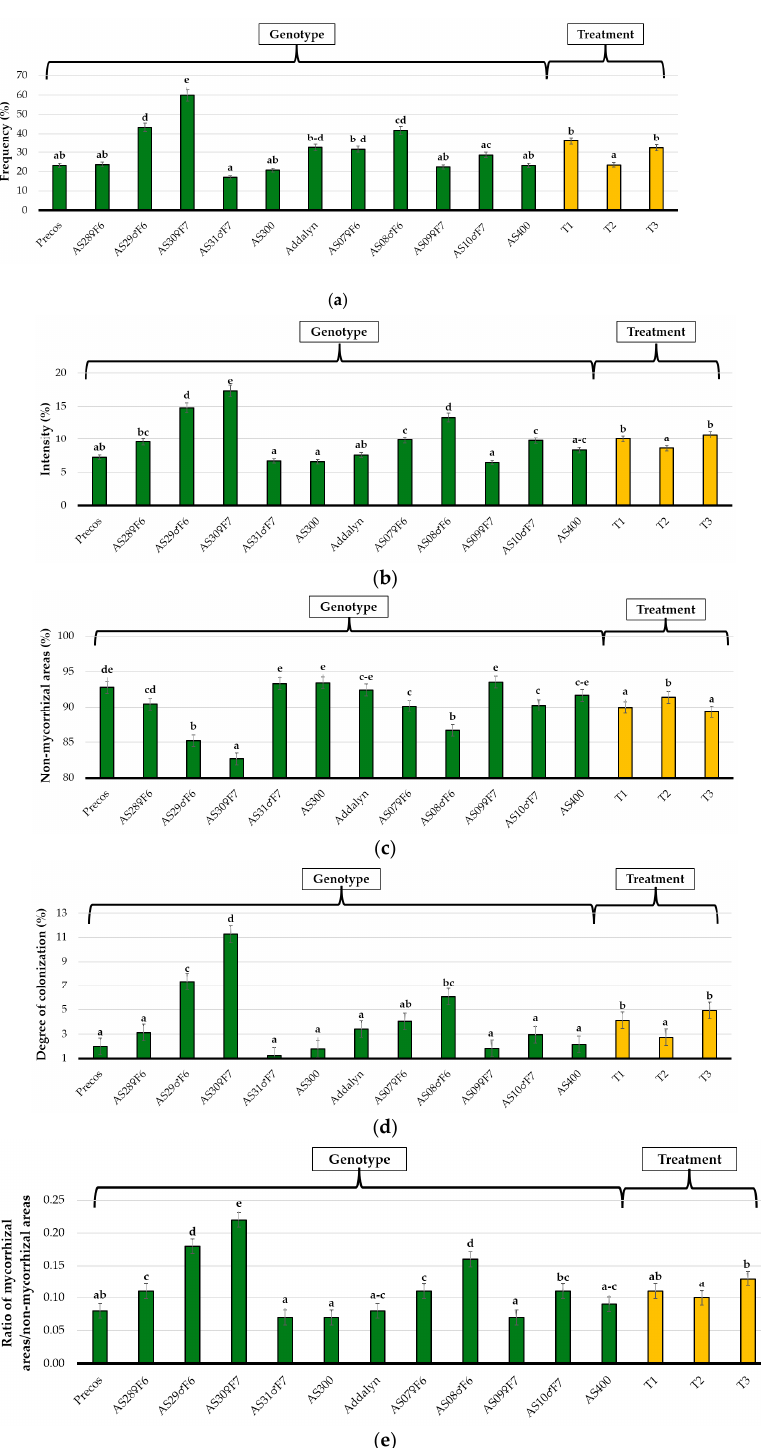
with the rest of the genotypes were not significant. The only exception was AS31 ♂ F7 with an average frequency lower than 20%, which was the minimum average for the entire set of genotypes. Of the three treatments, two did not show significant differences (T1 and T3), but both were significantly higher compared with T2. An interesting aspect was that the genotype set has a native mycorrhizal acceptance of over 35%, which was over 5% higher, but not significant, than the acceptance of the inoculum. Both these rates are sig- nificantly higher than the mycorrhizal acceptance of genotypes to which fertilizer was applied. This phenomenon is related to the reduction in the permissiveness of roots for fungal colonization due to the increased availability of nutrients in the root area.